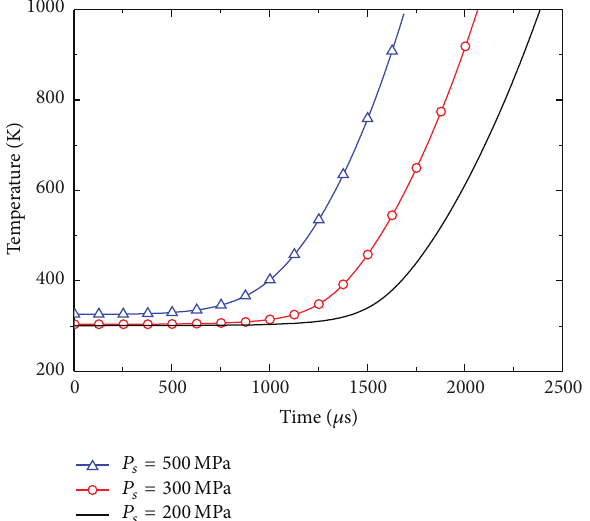
Figure 6: Time evolution of temperature at pore surface under lower pressures with the improved model.